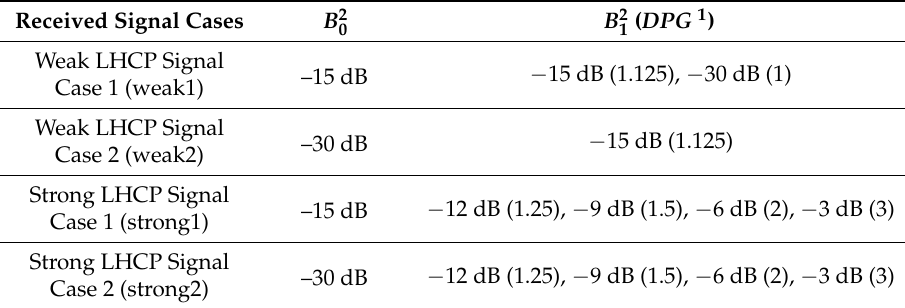
Table 2. The specific power level of the received LOS and MP signals in the LHCP